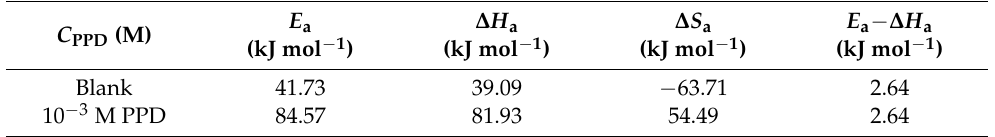
Figure 4. Arrhenius and transition Arrhenius plots of MS in 1.0 M HCl containing the optimal concentration of 10 − 3 M PPD. Table 4. Activation parameters for MS in the tested solution with and without PPD derived from the polarization